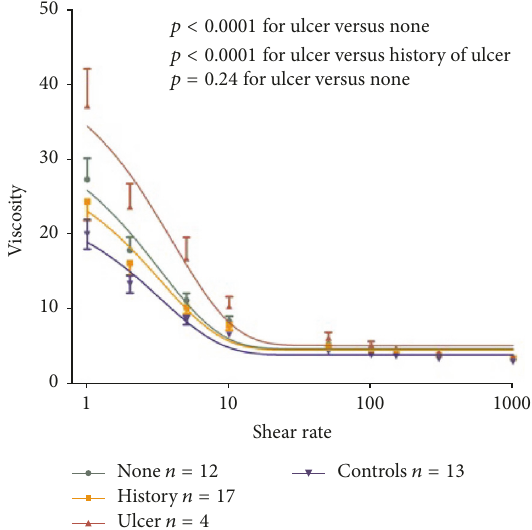
Figure 2: Whole blood viscosity in Systemic sclerosis patients . WBV was compared between patients with ulcers (red), a history of ulcers (yellow), and no history of ulcers (green). Control patients are also depicted (purple). WBV was significantly higher in patients with ulcers versus patients with a history of ulcers ( 𝑝 < 0.0001 ) and versus patients with no history of ulcers ( 𝑝 < 0.0001 ). By contrast, there was no difference between patients with a history of ulcers versus patients with no history of ulcers ( 𝑝 = 0.24